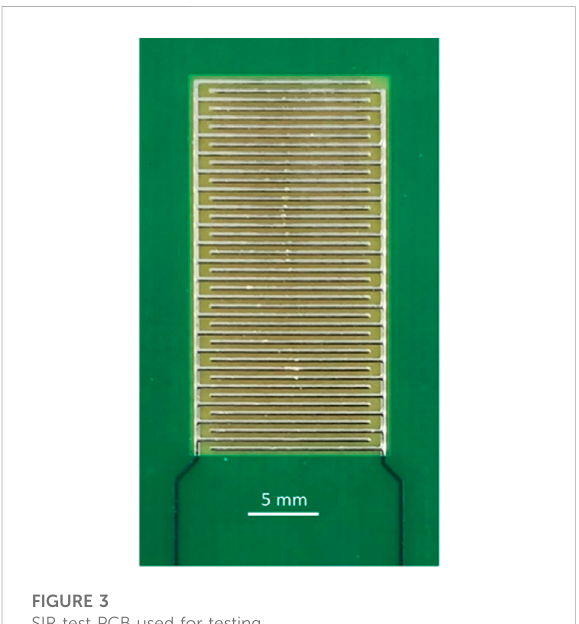
FIGURE 3 SIR test PCB used for